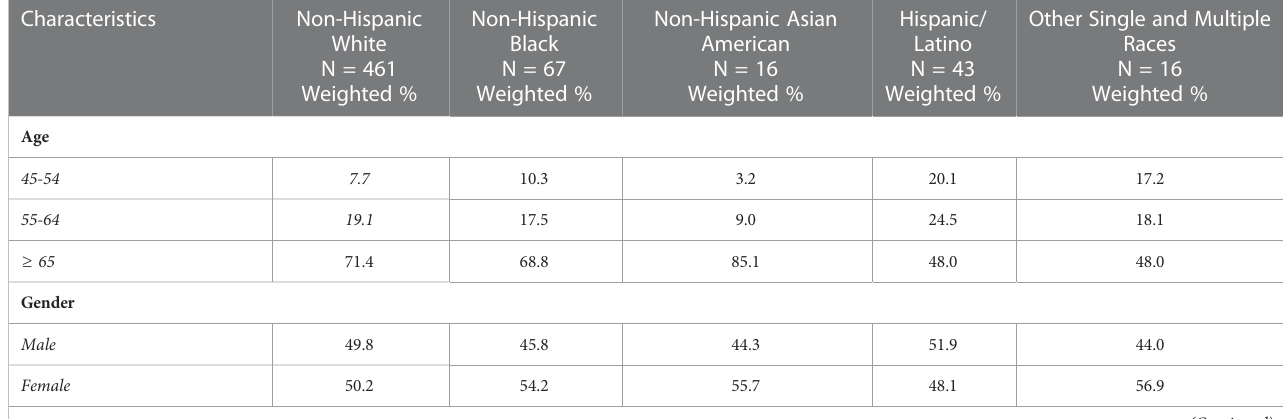
TABLE 1A Cancer Patients with/without Diabetes Characteristics by Racial and Ethnic Category, NHIS 2021 a,b .